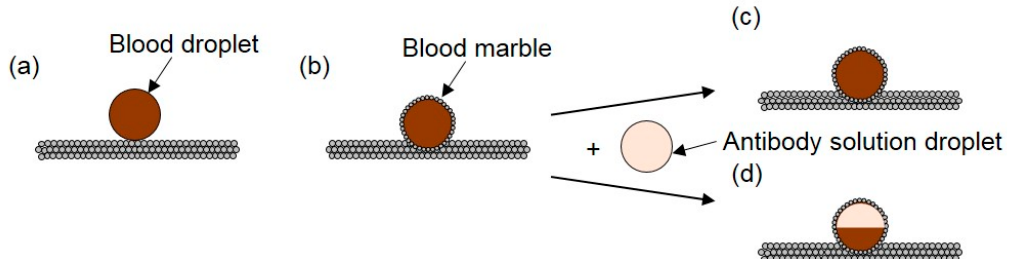
Figure 21. Schematic illustration of the microbioreactor for blood-type identification. ( a ) A blood droplet (10 μ L) is placed on a hydrophobic precipitated calcium carbonate powder bed to form the corresponding blood marble; ( b ) a droplet of antibody solution (10 μ L) is then injected inside the blood marble to complete the preparation of the microbioreactor; ( c ) when the corresponding antigens are not present on the surface of red blood cells, no separation is visible; ( d ) when the corresponding antigens are present, red blood-cell agglutination reaction will take place, which will result in the separation of marble color into two distinct light (top) and dark (bottom) parts.